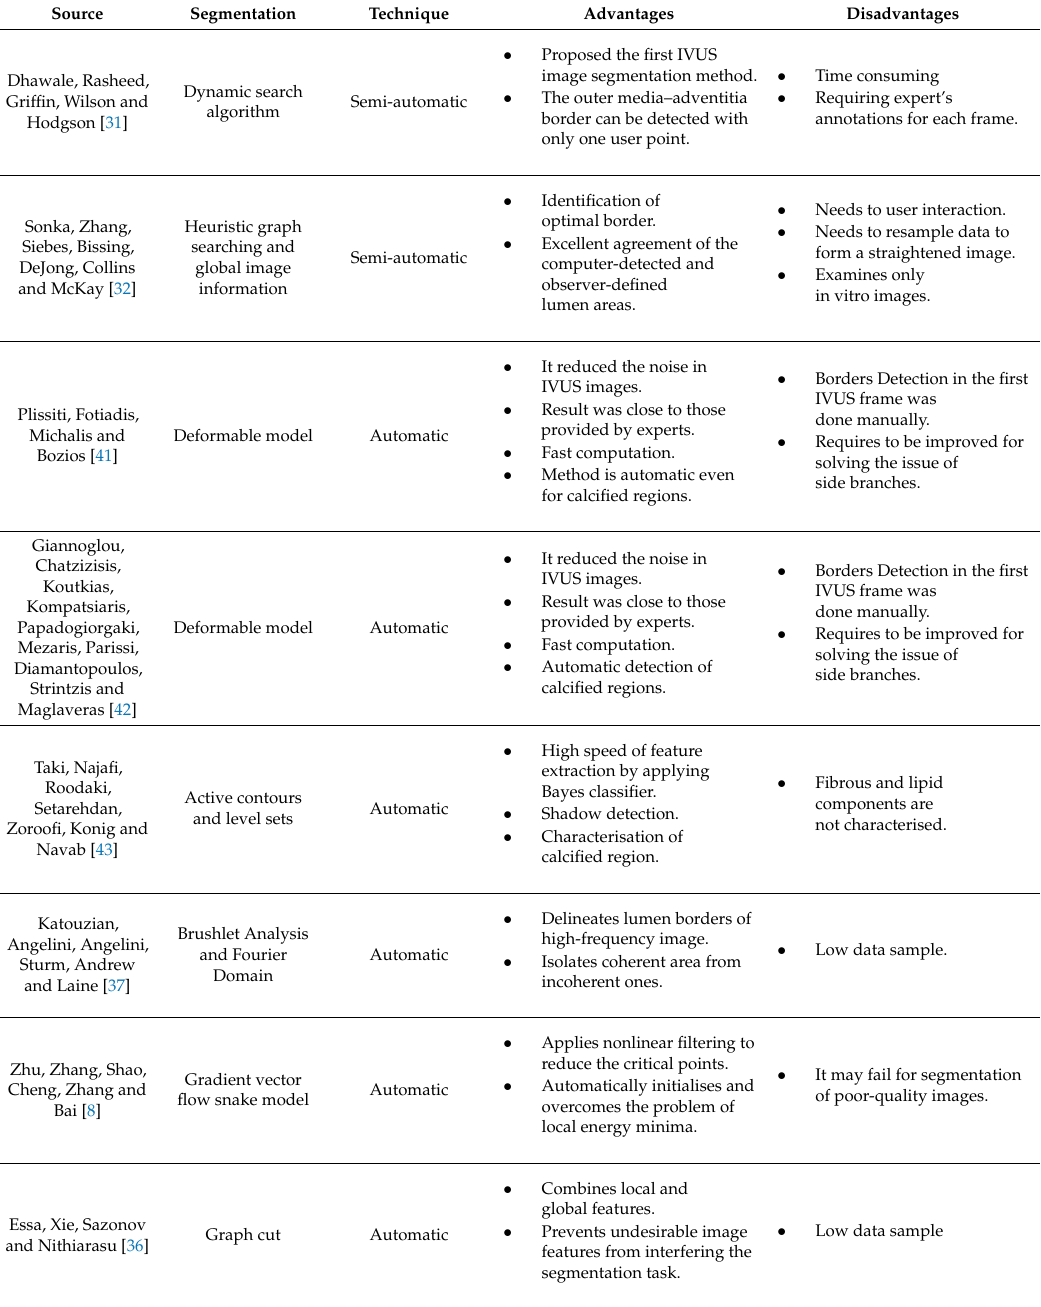
Table 1. IVUS image segmentation